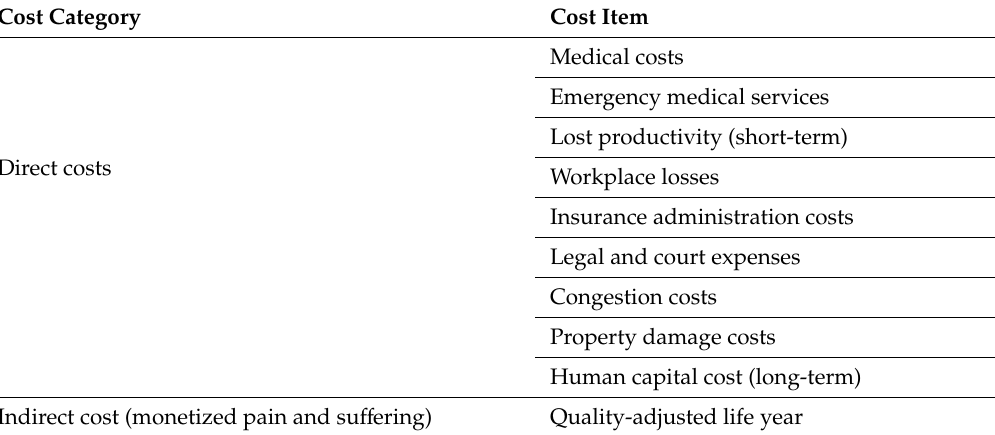
Table 1. Crash cost classification by